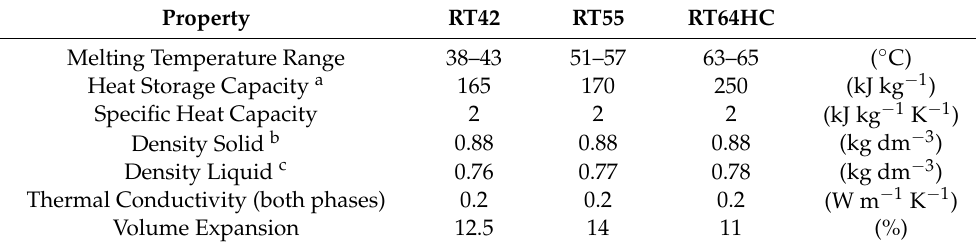
Table 2. Thermophysical characteristics of the tested paraffins. Data by the manufacturer